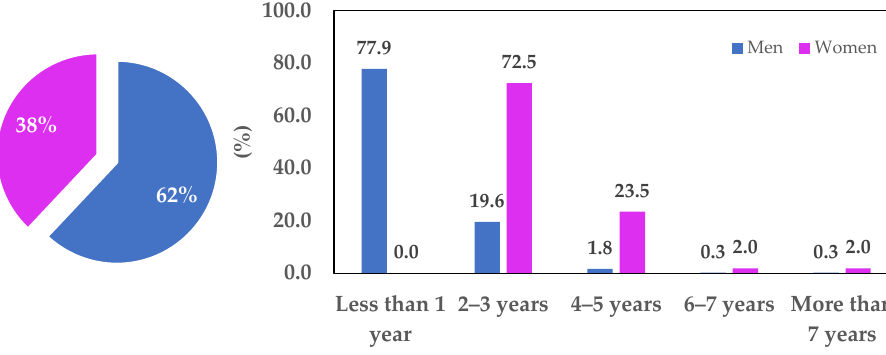
Figure 4. Distribution of respondents by gender ( left ) and enrolment ( right ).